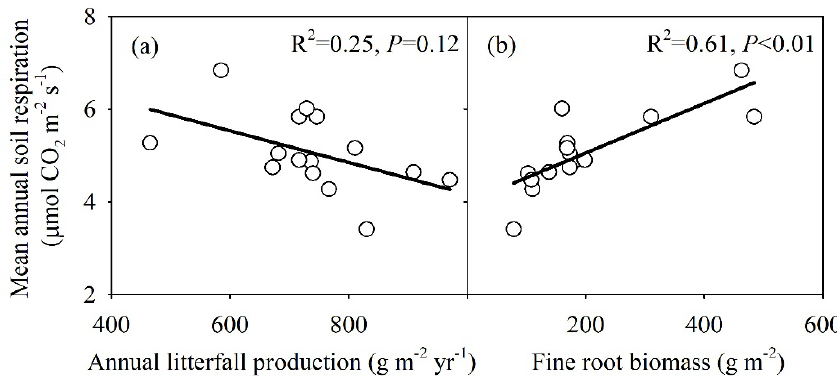
Figure 6. Relationships between annual litterfall production ( a ), fine root biomass ( b ), and mean annual soil respiration.